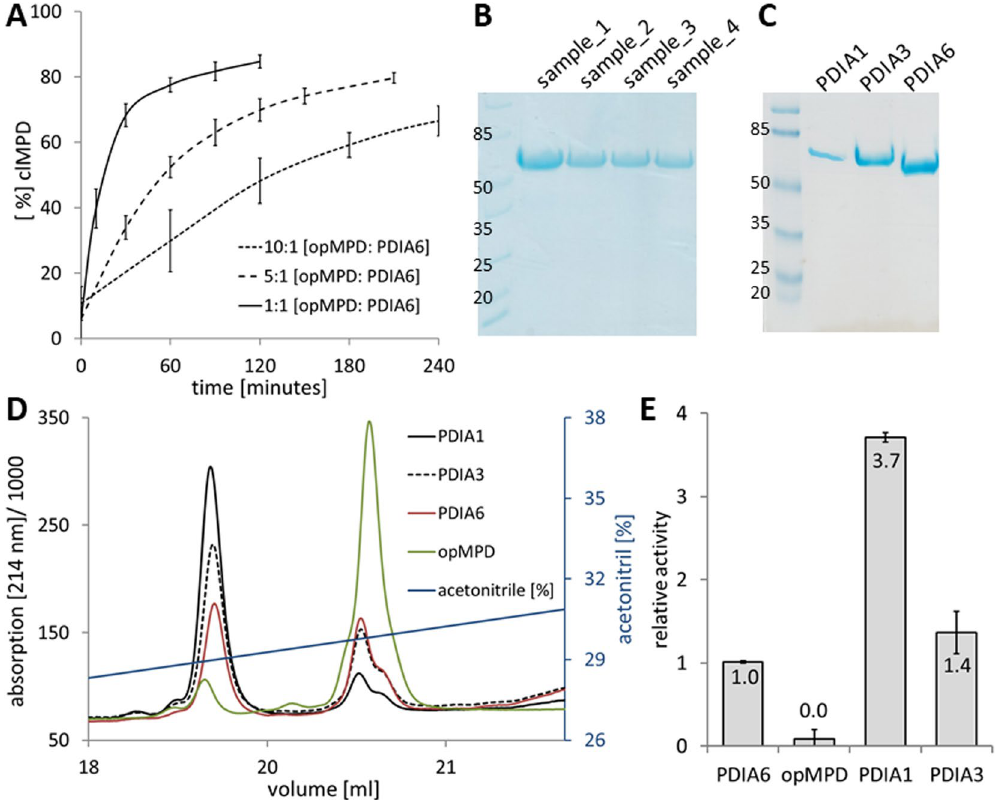
Figure 1. Catalytic activity of recombinant PDIs when performing isomerization of opMPD to clMPD. ( A ) Three time curves of the disulfide switch by using a 1:1, a 5:1, or a 10:1 ratio of opMPD to PDIA6. The percentage of clMPD was taken as measure of activity. ( B ) SDS-PAGE of four different samples was used to confirm the integrity of PDIA6 after incubation. ( C ) Purity of recombinant PDIs was verified by SDS PAGE. ( D ) RP-HPLC chromatogram of the conversion of opMPD to clMPD by reduced PDIs. Green line: non-treated opMPD; Black line: MPD treated with PDIA1; Dotted black line: MPD treated with PDIA3; Red line: MPD treated with PDIA6. ( E ) Histogram of the average PDI activities (relative to PDIA6) as calculated by peak areas from the data given in ( D